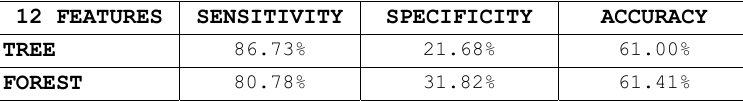
Table 13. One color slope value